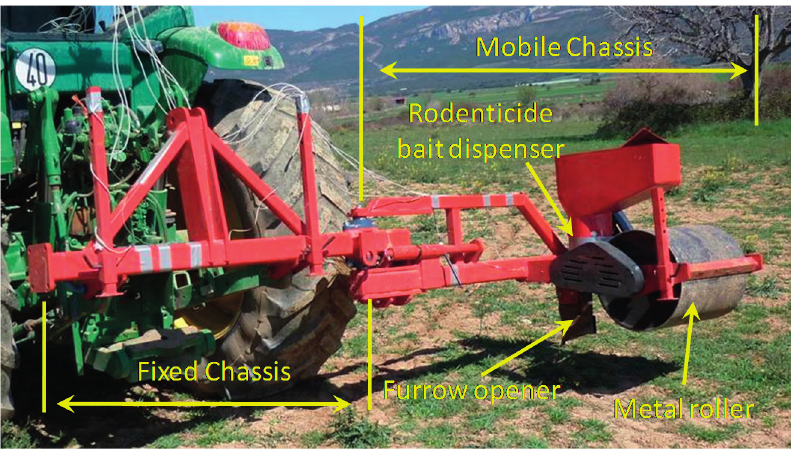
Figure 1. Components of the agricultural implement prototype: (1) fixed chassis; (2) mobile chassis; (3) furrow opener; (4) rodenticide bait dispenser; (5) metal